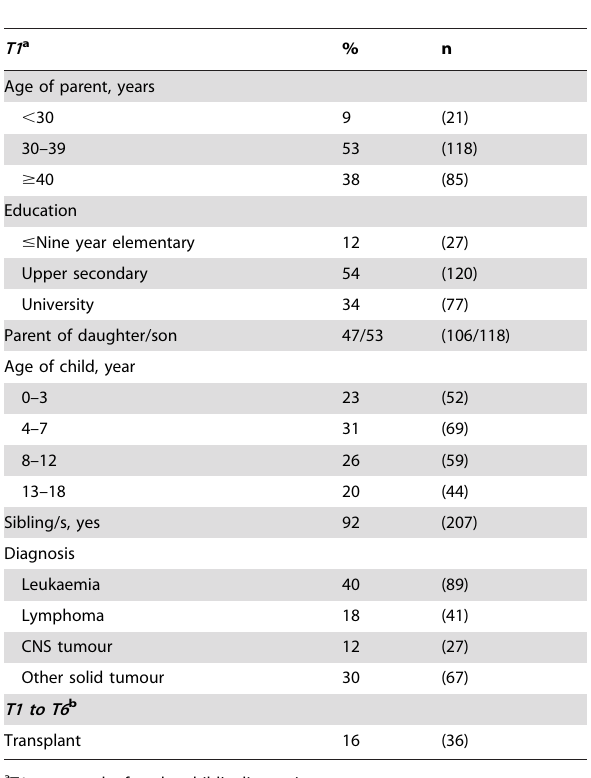
Table 1. Parent (N =224) and child